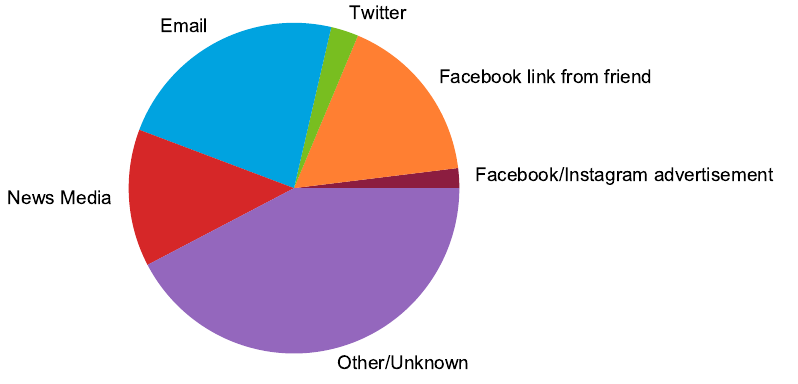
Figure 1. Where respondents heard about the